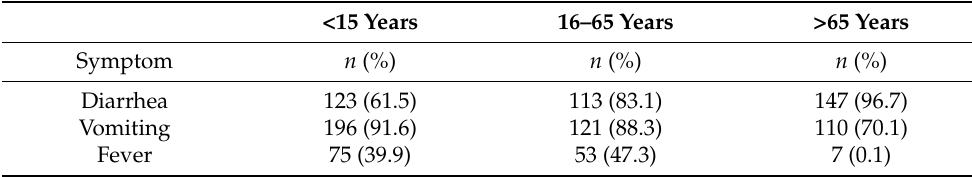
Table 3. Distribution of cases according to symptoms and age